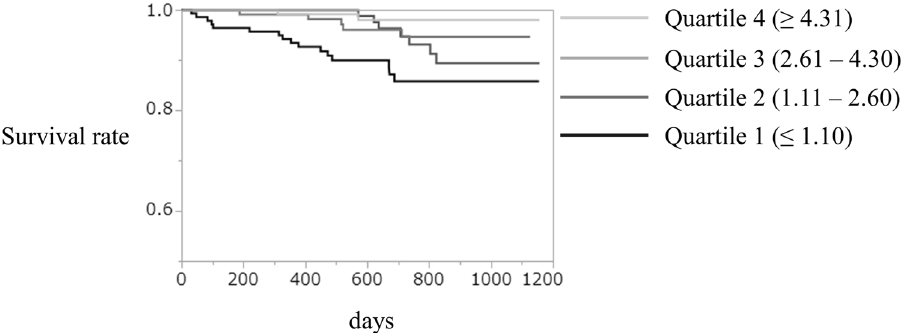
Figure 2. The Kaplan–Meier survival curve stratified according to perfusion index at